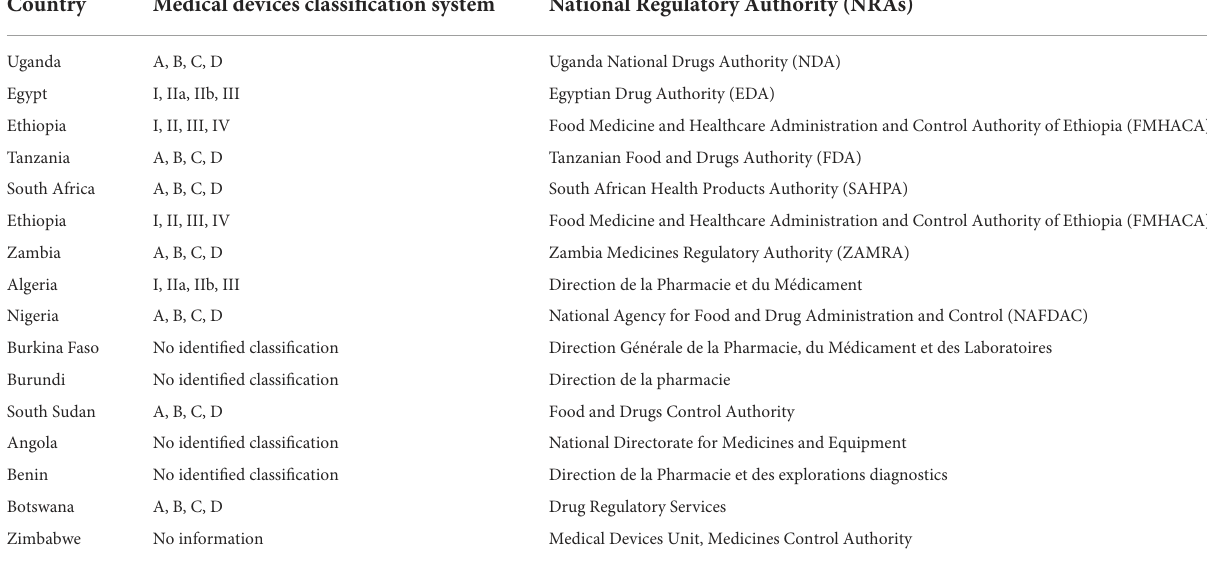
TABLE 1 Medical devices classification systems in some African countries and the responsible National Regulatory Authorities.